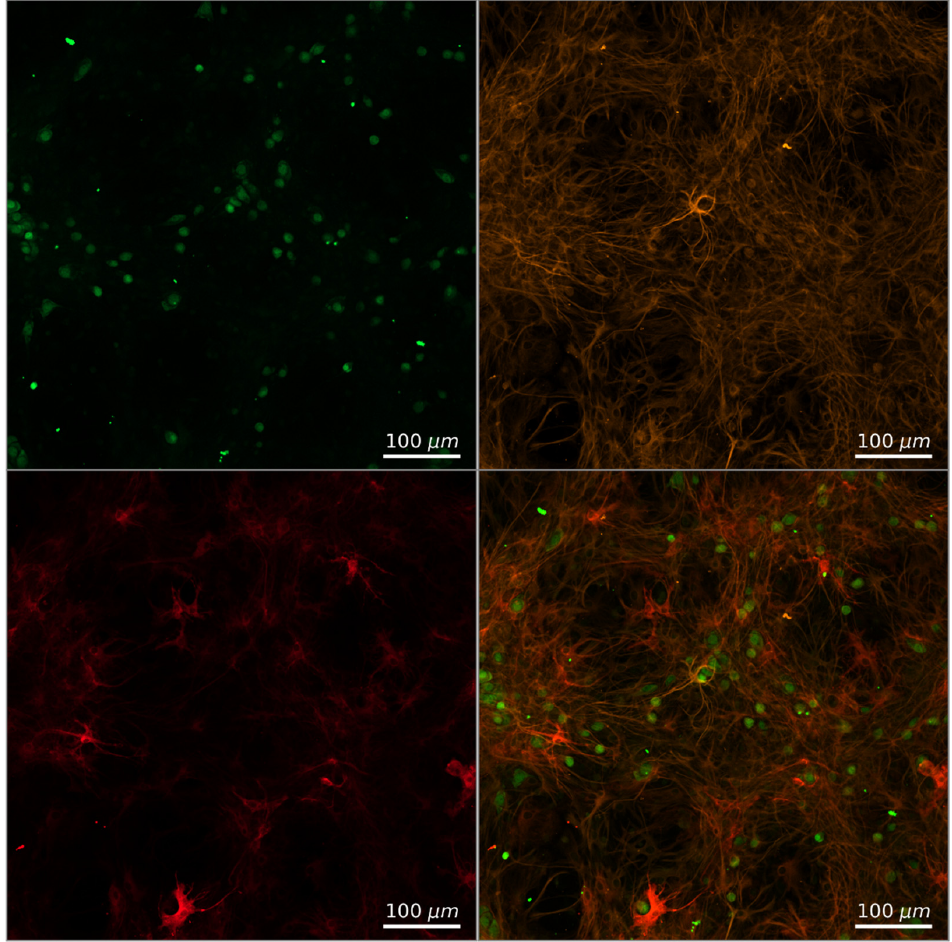
Figure 12. A representative example of immunocytochemical staining of a culture of cocultivated astrocytes treated with AB42 and healthy nerve cells. Green channel—neurons labeled with primary anti-NeuN antibodies and secondary antibodies AlexaFluor 488; orange channel—astrocytes labeled with primary anti-GFAP antibodies and secondary antibodies AlexaFluor 555; red channel—cortical astrocytes transduced with AAV-CMV-mCherry prior to cocultivation. Scale bar: 100 μ m. A Plan-Apochromat 10×/0.3 lens was used to acquire the images.